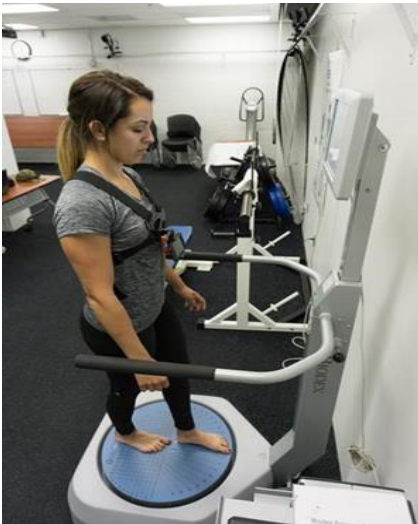
Figure 1. Demonstration of using the Biodex Balance System SD while simultaneously using the Sway Medical Application on the iPod device during the Balance Error Scoring System test.